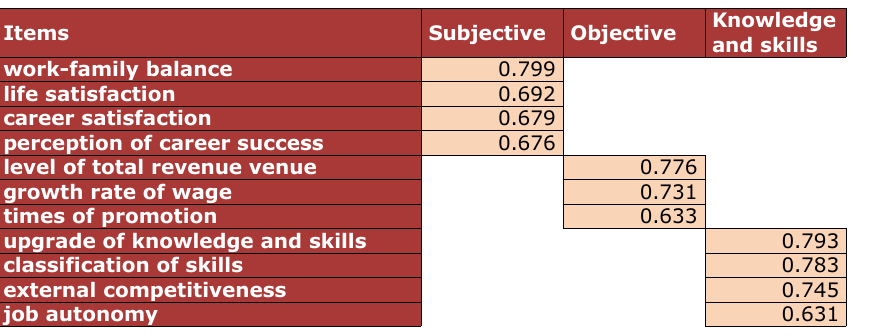
Table 4. Rotation factor loading matrix (N=230)